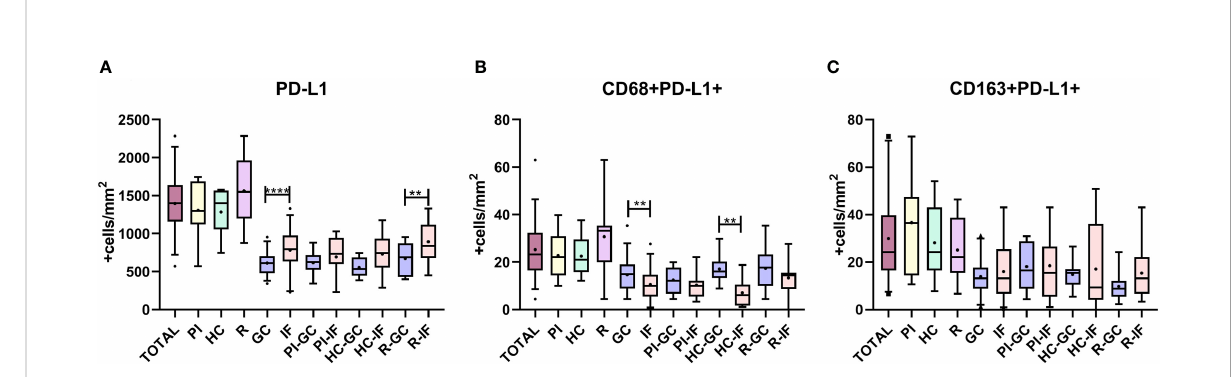
FIGURE 1 Histological distribution of PD-L1. (A) Total PD-L1 expression in the germinal center (GC) and interfollicular region (IF) in the entire cohort (Total), in primary infected patients (PI), healthy carriers (HC), and patients undergoing reactivation (R); (B) CD68 macrophages ’ PD-L1 expression in the germinal center (GC) and interfollicular region (IF) in the entire cohort (Total), in primary infected patients (PI), healthy carriers (HC), and patients undergoing reactivation (R); (C) CD163 macrophages ’ PD-L1 expression in germinal center (GC) and interfollicular region (IF) in the entire cohort (Total), in primary infected patients (PI), healthy carriers (HC), and patients undergoing reactivation (R) **p < 0.01, ****p <